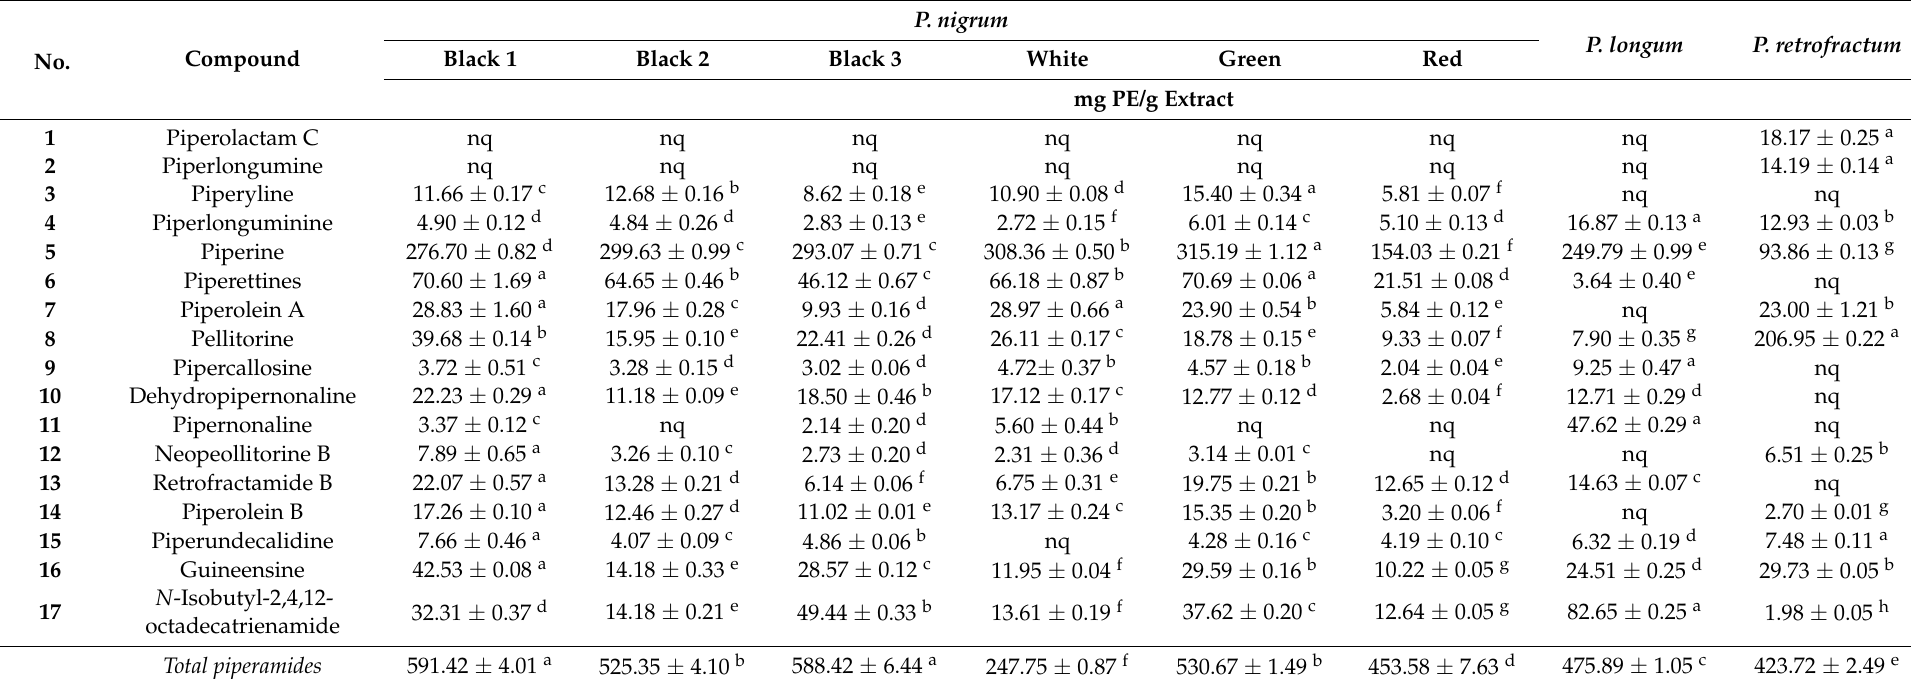
Table 3. Piperamide content in the methanolic fruit extracts obtained from different spices of genus Piper